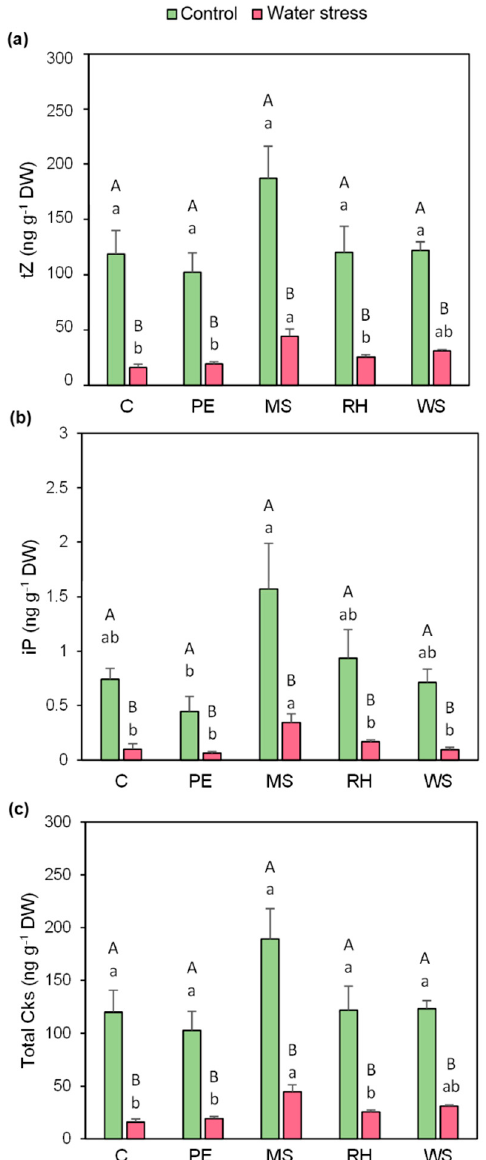
Figure 4. ( a ) Trans-zeatin (tZ), ( b ) isopentenyladenine (iP), and ( c ) total cytokinin (CKs) concentrations in leaves of escarole plants of the commercial variety “Brillantes” non-mulched or subjected to different mulching treatments and cultivated under control (well-watered) and water stress (70% ETc) conditions. Bars show the means of five plants ± standard error. Different capital letters indicate significant differences due to the water stress treatment while different small letters show significant differences among mulching treatments according to Tukey’s test ( p ≤ 0.05). Abbreviations used: non-covered substrate (C), polyethylene mulch (PE), mushroom substrate-based hydromulch (MS), rice hulls-based hydromulch (RH), and wheat straw-based hydromulch (WS).